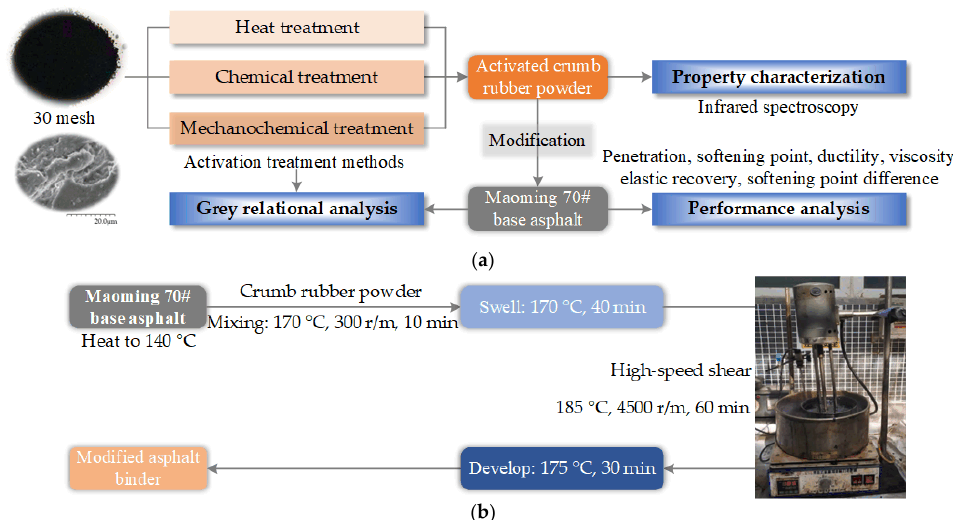
Figure 2. The experimental scheme and asphalt binder sample preparation: ( a ) the flow chart of this study; and ( b ) the asphalt binder sample preparation. Based on the properties of the activated crumb rubber powder by using different ac- tivation modes, the corresponding activated crumb-rubber-powder-modified asphalt